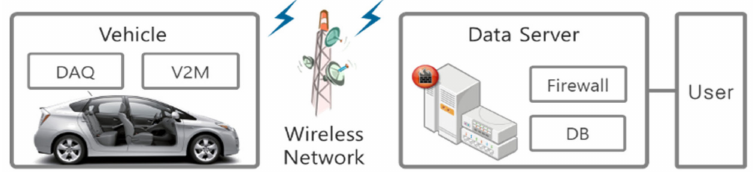
Figure 1. Schematic of the real-time monitoring